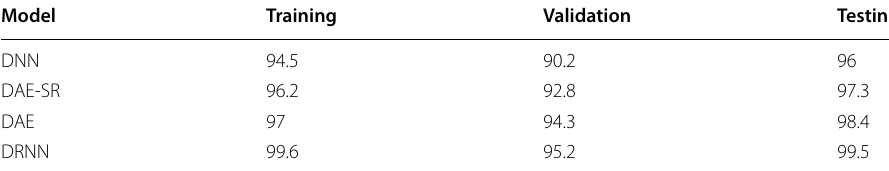
Table 10 Evaluation of accuracy with respect to training, validation and testing Model Training Validation Testing DNN